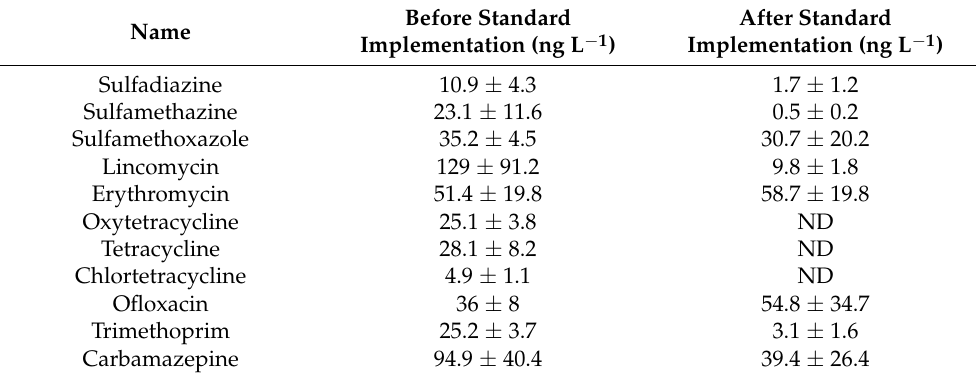
Table 2. Concentrations of PPCPs (ng L − 1 ) in the Daqing River Basin, before and after (this study) the implementation of the new standard (DB 13/2795–2018).